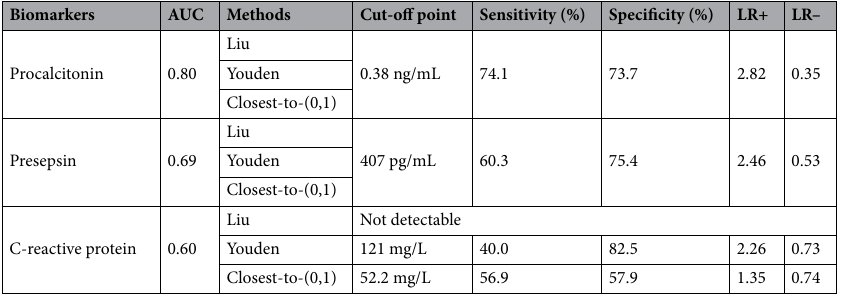
Table 3. Optimal cut-off values and diagnostic performance of biomarkers for predicting bacteremia. AUC, area under the curve; LR, likelihood